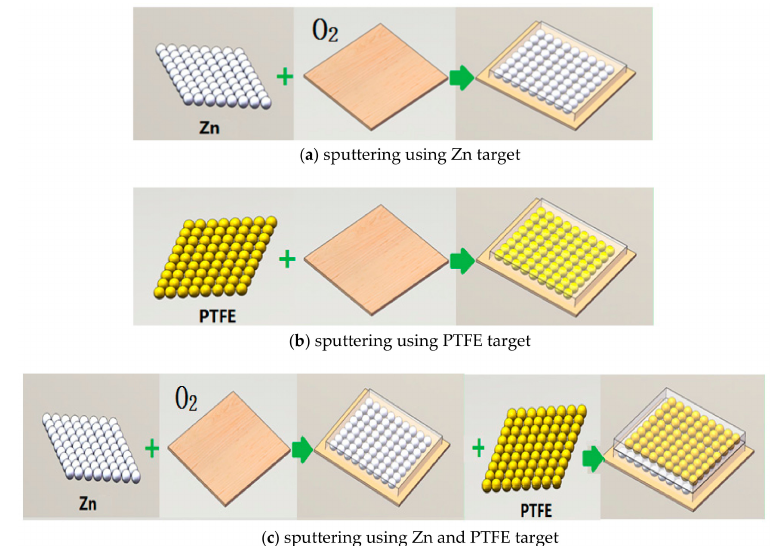
Figure 3. Radio frequency (RF) magnetron sputtering functional film on the surface of cellulose